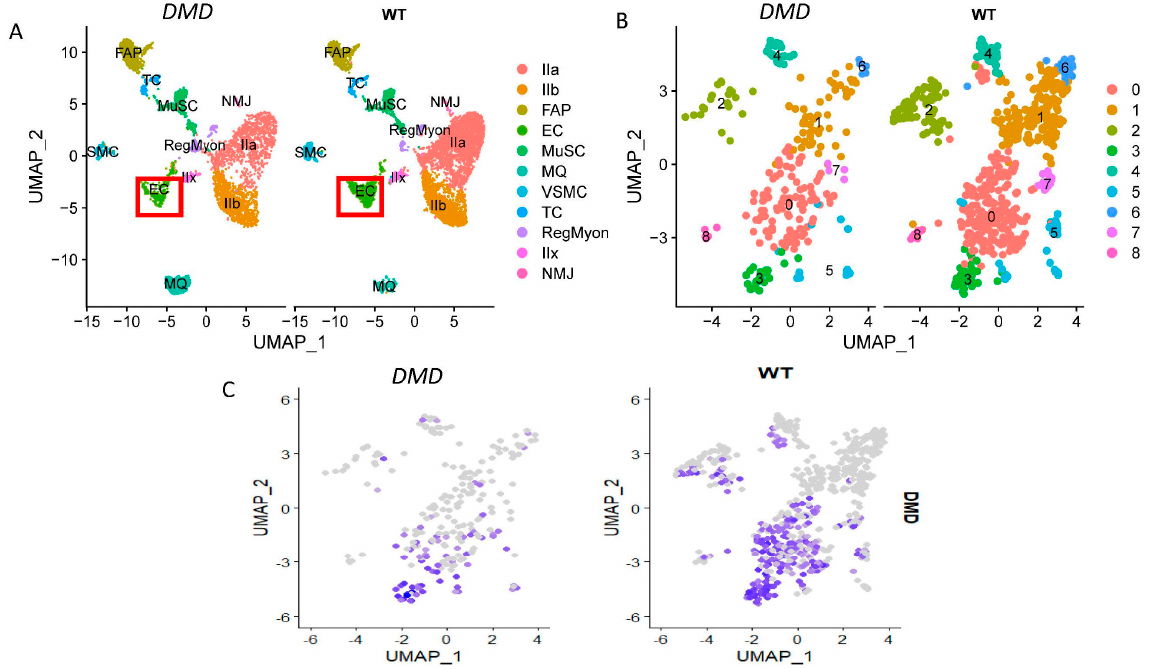
Figure 1. Single-nuclei RNA sequence analyses. ( A ) Split view of UMAP plot representation of muscles-derived nuclei from the DMD mut and wild-type (WT) mouse samples. Each major cell type was represented in a different color. A red square indicates EC subsets from muscle nuclei. IIa: type IIa myocytes, IIb: type IIb myocytes, IIx: type IIx myocytes, FAP: fibro/adipogenic progenitor cells, EC: